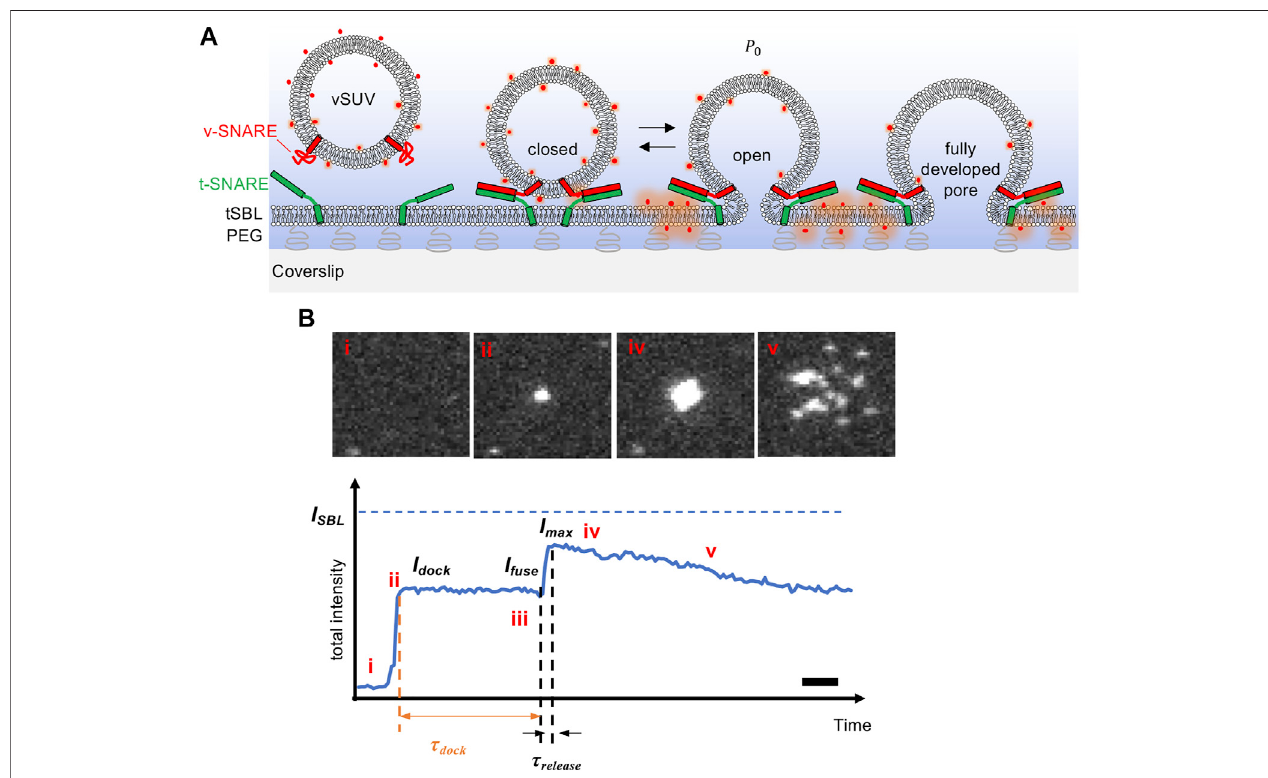
FIGURE 1 | Intensity changes during liposome-supported bilayer fusion, detected using TIRF microscopy with s-pol excitation. (A) Schematic of the experiment. Small unilamellar vesicles reconstituted with neuronal/exocytic v-SNARE proteins (vSUVs) are labeled with a fl uorescent lipid whose excitation dipole is nearly parallel to the membrane. The vSUV docks onto and fuses with a planar bilayer supported on a coverslip, and reconstituted with cognate t-SNAREs (tSBL). The membranes contain 5 mol % PEGylated lipids in order to avoid direct contact of the SBL with the coverslip. Only PEGylated lipids under the SBL are shown for clarity. Once a fusionporeisestablished,itcan fl ickeropen-closed(spendingafraction P o ofthetimeintheopenstate),beforeeventuallyexpandingorresealing.Duringfusion,thetotal fl uorescence intensity around the fusion site increases as the fl uorophores are transferred into the SBL, because the fl uorophores are excited more ef fi ciently in the SBL than theSUV. (B) Anexample ofavSUV-tSBLfusionevent.Top: Snapshots extracted froman imagestackrecordedat56 Hz. Every boxis11 μ m -by- 11 μ m (43pixels by43pixels).Bottom:thetotalintensity(sumofpixelvalues)ina22 μ m -by-22 μ m boxcenteredaroundthedockingsite,asafunctionoftime,fortheeventshownabove. vSUVswerelabeledwith1 mol%LR-PEandexcitedat561 nminTIRFM.Becausetheevanescent fi eldisveryshallow,vSUVsthatare ≳ 100 nmawayfromtheSBLare notvisible.Uponinitialdocking,a fl uorescentspotappearsandtheintegratedintensityrapidlyincreasestoanewvalue(i – ii).Membranefusioncausesarapidincreasein intensity to I max (iii – iv), which is < than the values I SBL that would be reached were there no photobleaching. After suf fi cient time, individual lipid-linked fl uorophores becomevisibleastheydisperse and photobleach (v).Thebox ischosenlargeenough thatno fl uorophoreshaveyetleftthebox. Fittingtheintensitytrace toamodel, the parameters shown on the fi gure are extracted. Scale bar (cid:1) 200